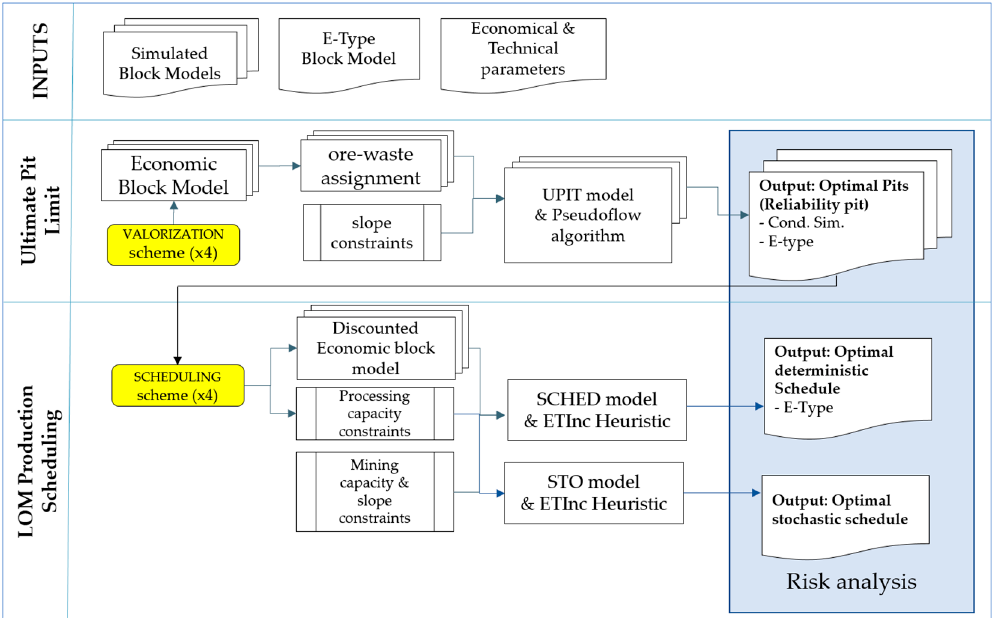
Figure 5. Flow chart representing the proposed methodology.